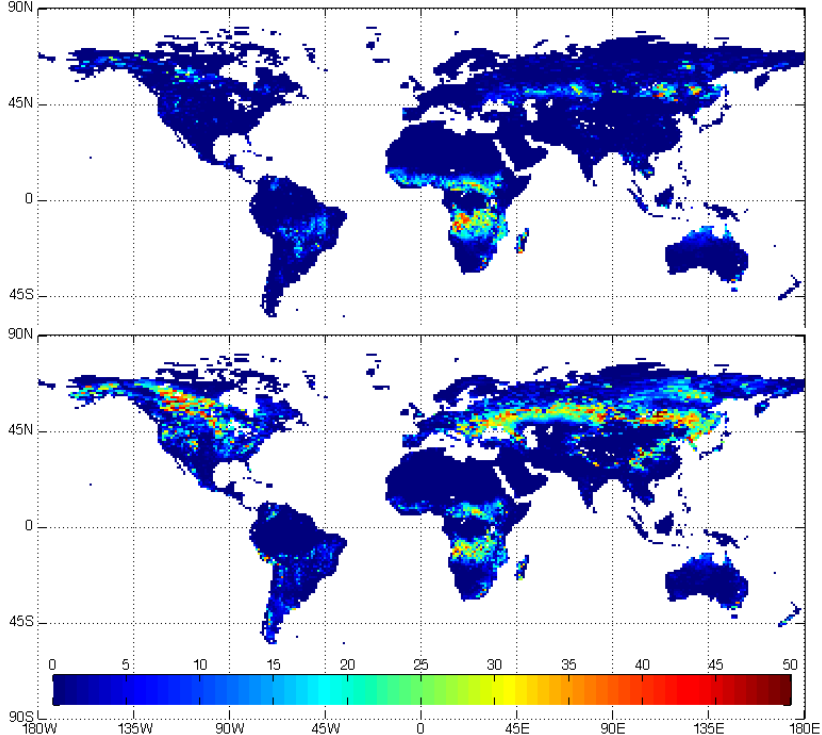
Fig. 3. CO emissions in gCm − 2 yr − 1 for c w = 0 . 2 and Emission Model 1, average 2001–2006. Upper panel: GFED3 burned area. Lower panel: L3JRC burned